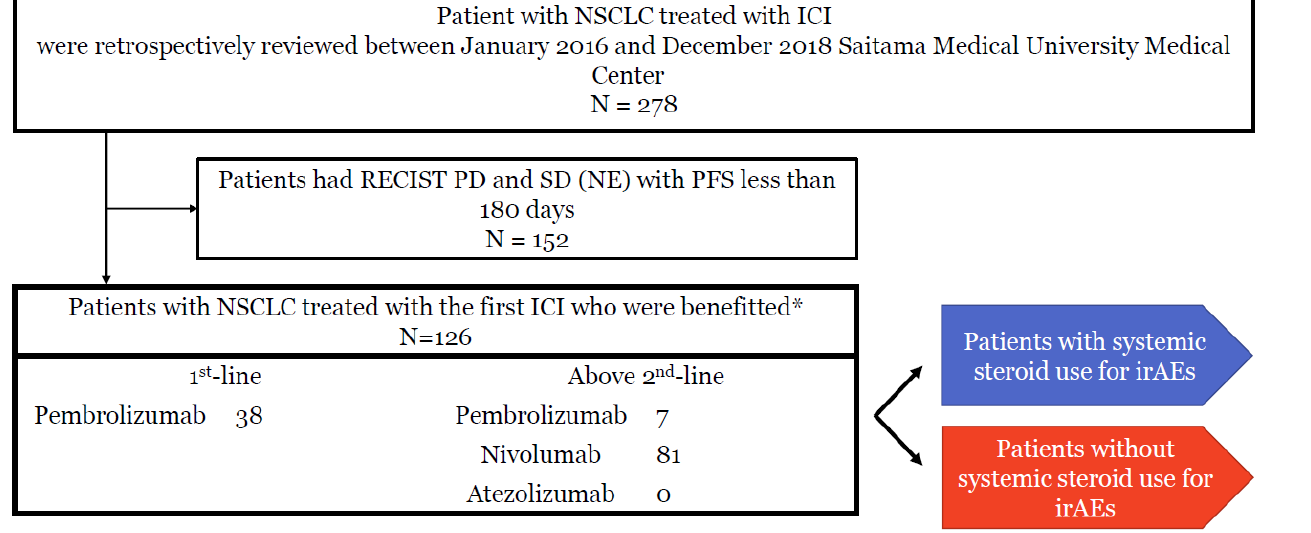
Figure 1. Study scheme. Among 278 patients with advanced NSCLC who received ICI monotherapy within the study period, 152 patients who had RECIST PD and SD or NE with PFS less than 180 days were excluded; 126 patients who were benefitted from ICI monotherapy were enrolled as the target population. The enrolled patients were divided into two groups: with and without systemic steroid use for irAEs. CR, complete response; PR, partial response; PD, progressive disease; NE, not evaluable. * Clinical benefit defined as RECIST CR/PR or SD and PFS of more than 180 days.